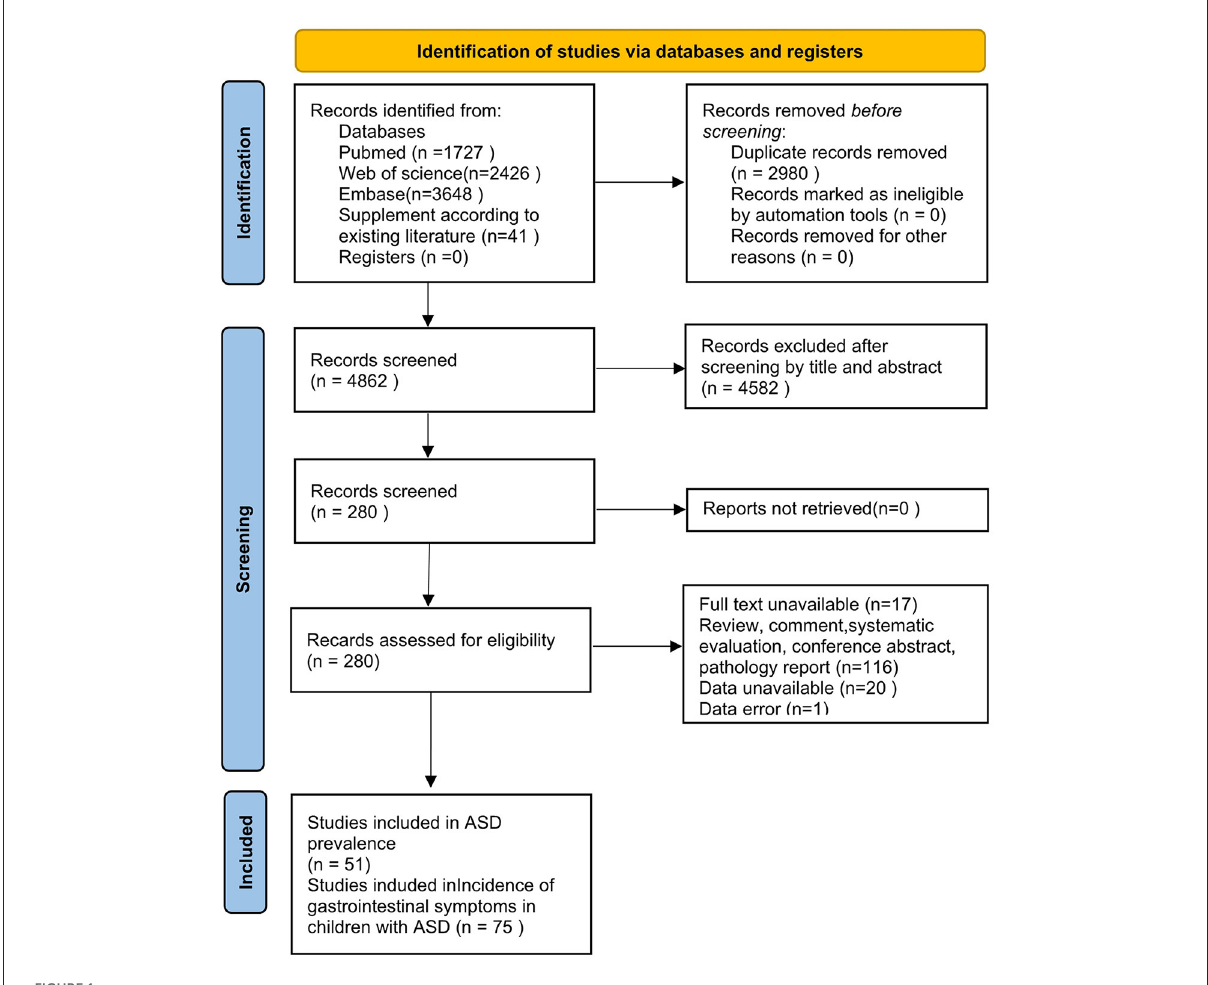
FIGURE1 Literature screening flow